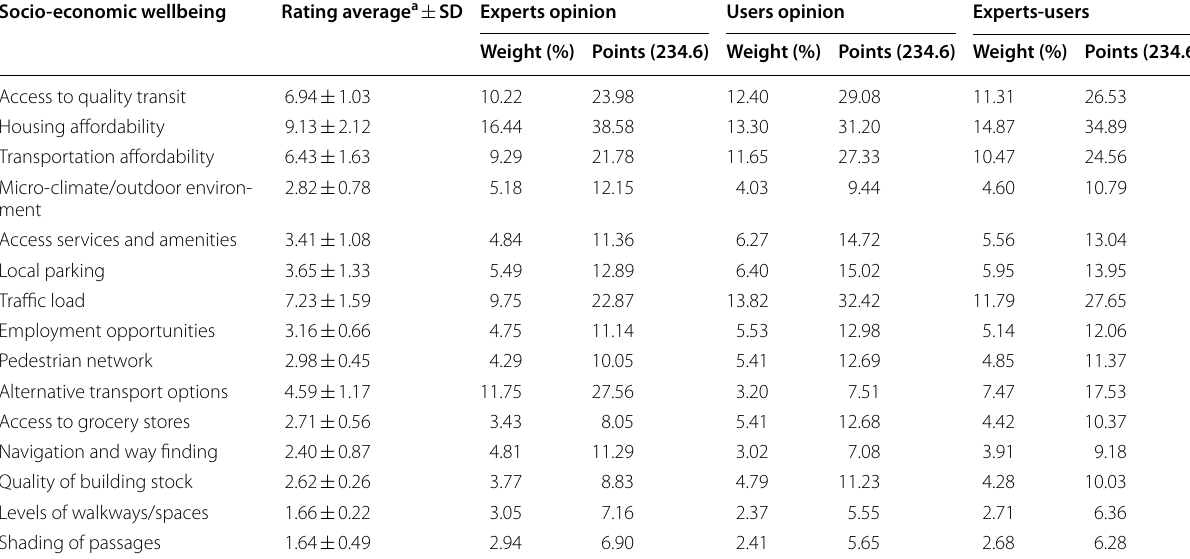
Table 3 Rating and weights of factors in the socio-economic wellbeing category